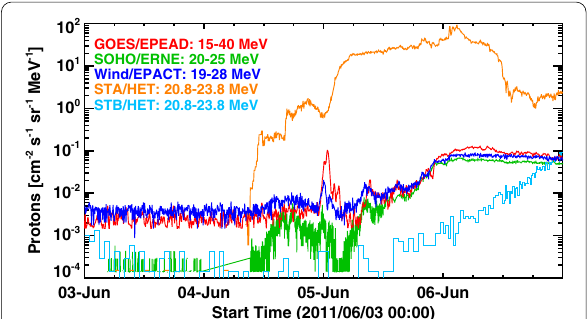
Fig. 1 Overview of the energetic proton observations by GOES, SOHO, Wind, STEREO-A, and STEREO-B from 3 to 6 June 2011. The GOES satellite measured an unusual enhancement of protons in the 15–40 MeV energy range at around 0 UT on 5